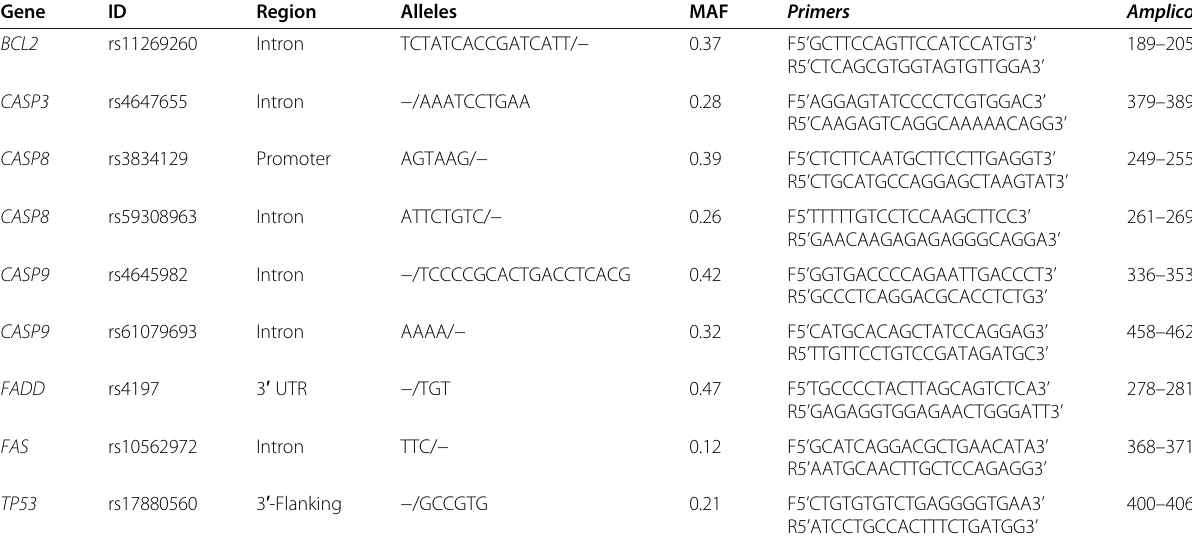
Table 1 Technical characterization of the markers included in the